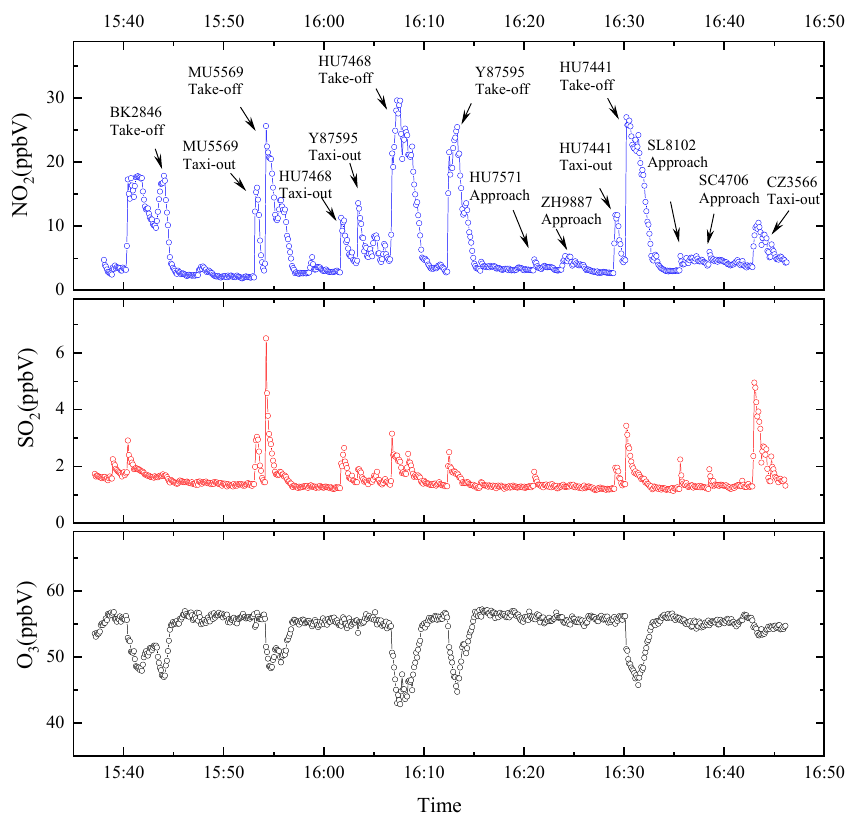
Figure 5. Temporal variation in the concentrations of NO 2 , SO 2 , and O 3 between 15:35 and 16:45 on 17 October 2019. 17 October